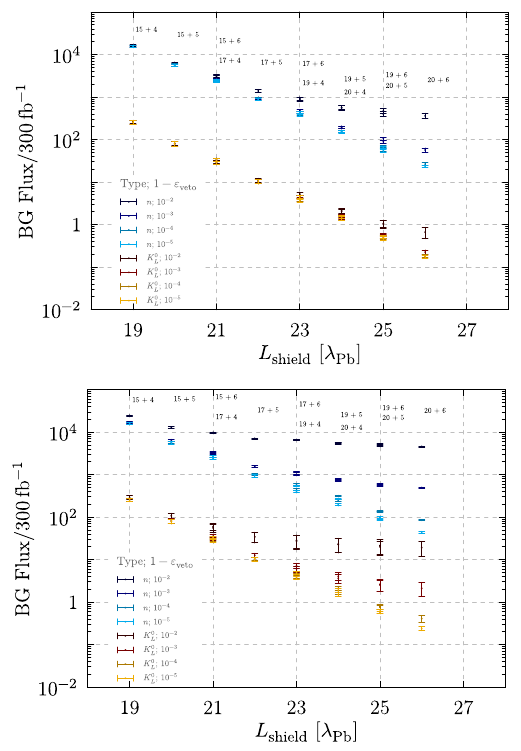
Fig. 24 Neutron (black-blue palette) and K 0 (red-yellow palette) L background fluxes with kinetic energy E kin > 0 . 4GeV versus total Pb shield depth in λ Pb , under variation of the shield configuration and veto efficiency, including the charged-neutral correlation veto (top) and without the charged-neutral correlation veto (bottom). For each value of the total shield depth, the (possibly multiple) corresponding configu- rations “ L pre-veto + L post-veto ” are shown by the adjacent labels in units of λ Pb